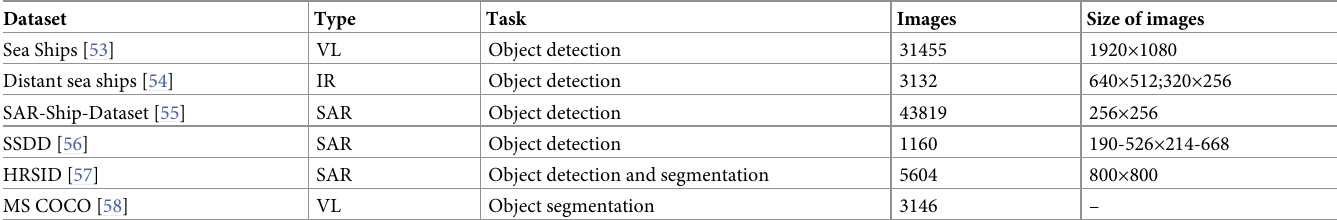
Table 1. Overview of several existing open-source datasets of marine ships.